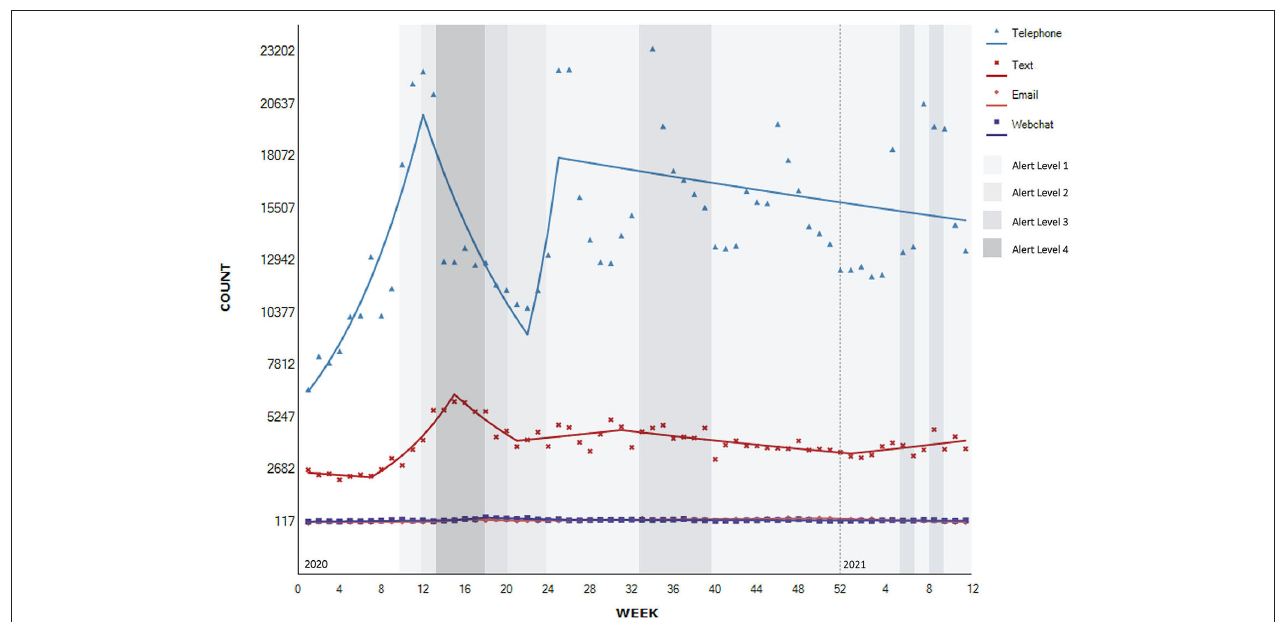
FIGURE 4 | Segmented regression analysis of contacts to national helplines per contact type ( N =